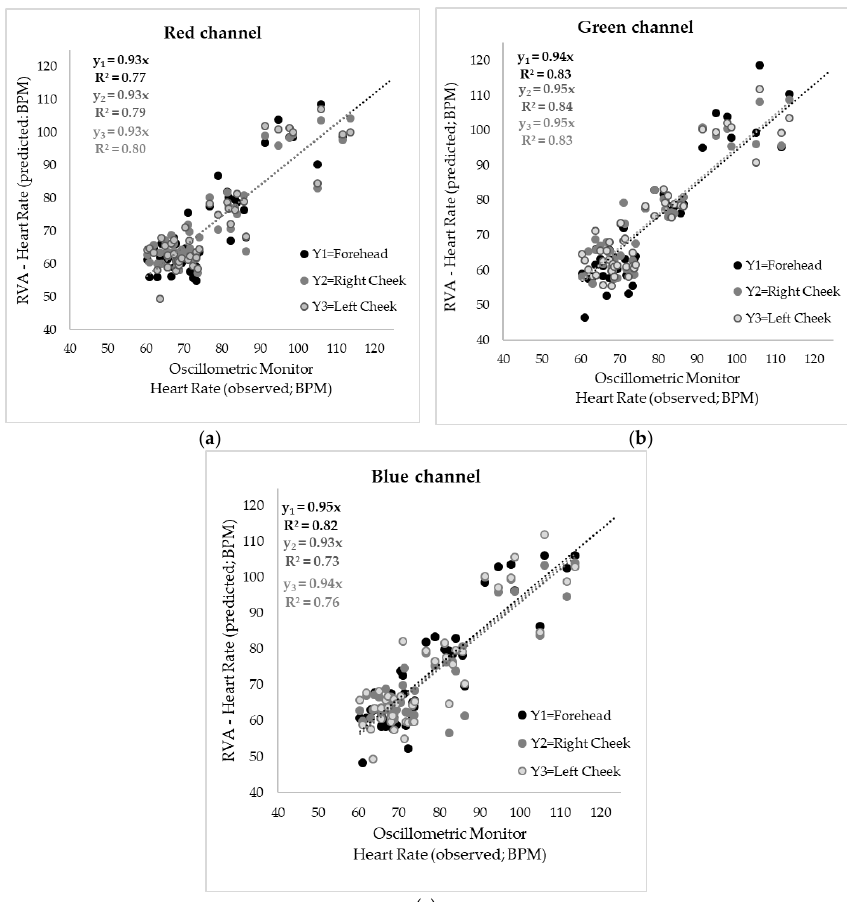
Figure 6. Correlations between heart rate (HR) measured using the oscillometric monitor (x-axis) and video analysis using the raw video HR algorithm (RVA) (y-axis) in beats per minute (BPM). The figure shows the results of the videos analyzed using the luminosity changes in ( a ) the red channel, ( b ) the green channel and ( c ) the blue channel. R 2 = determination coefficient. Sensors 2018 , 18 , x FOR PEER REVIEW